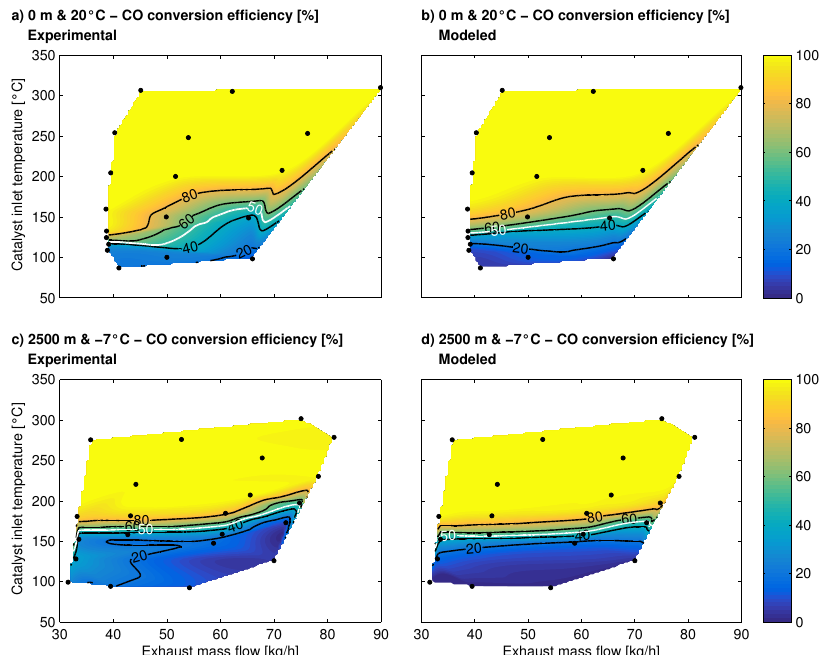
Figure 4. CO conversion efficiency as a function of the exhaust mass flow and catalyst inlet tempera- ture: ( a ) experimental results at 0 m and 20 ◦ C; ( b ) modeled results at 0 m and 20 ◦ C; ( c ) experimental results at 2500 m and − 7 ◦ C; and, ( d ) modeled results at 2500 m and − 7 ◦